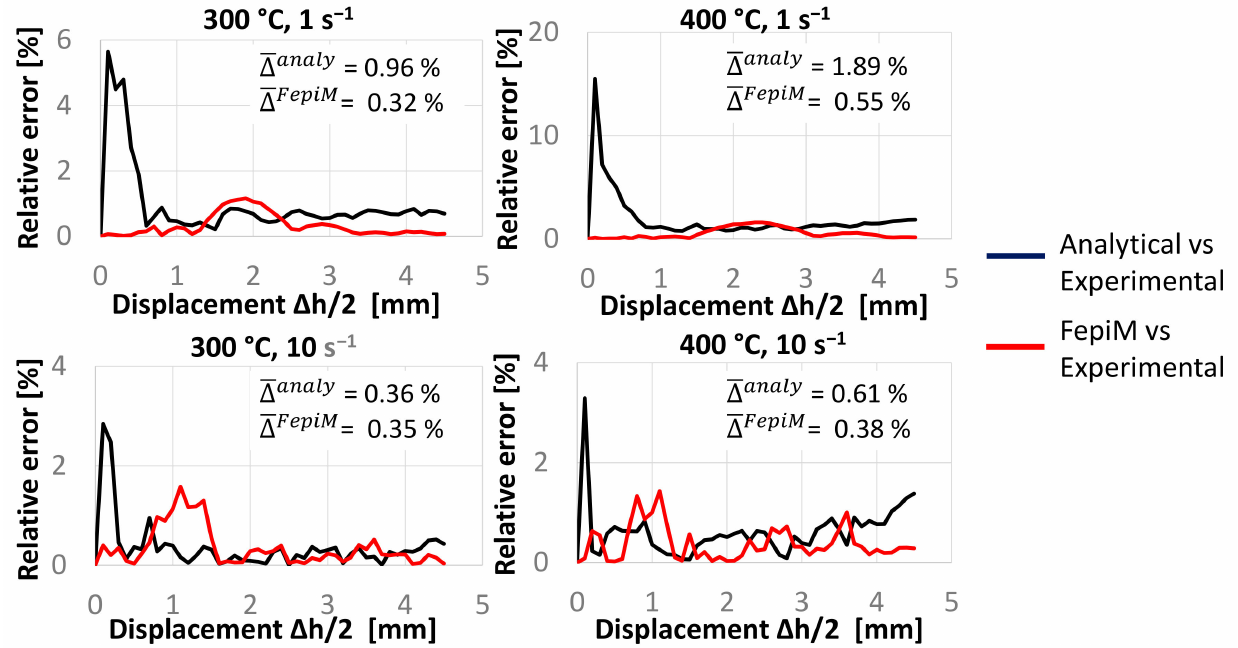
Figure 9. Validation analysis for some aluminum flow